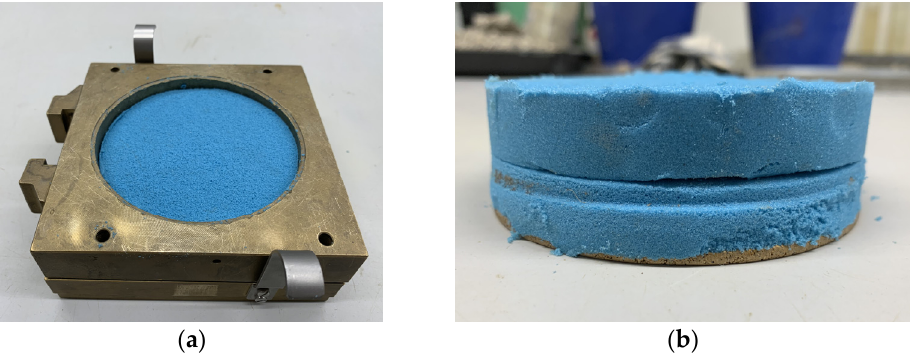
Figure 13. Kinetic sand after sliding. ( a ) Sample in the container; ( b ) Sample removed from the container with visible shear